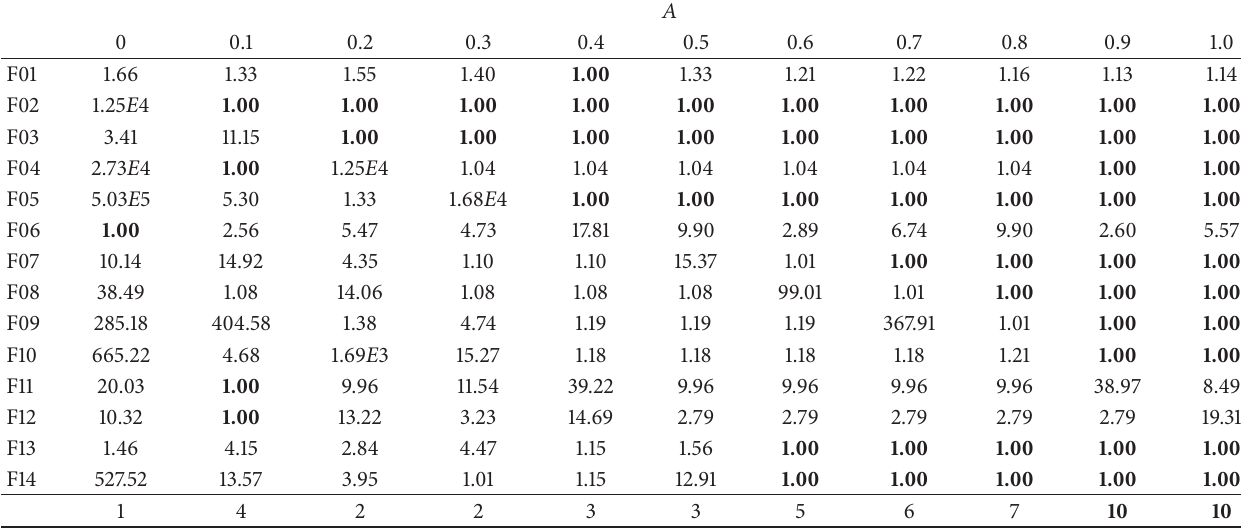
Table 5: Best normalized optimization results in fourteen benchmark functions with different 𝐴 . The numbers shown are the best results found after 100 Monte Carlo simulations HS/BA